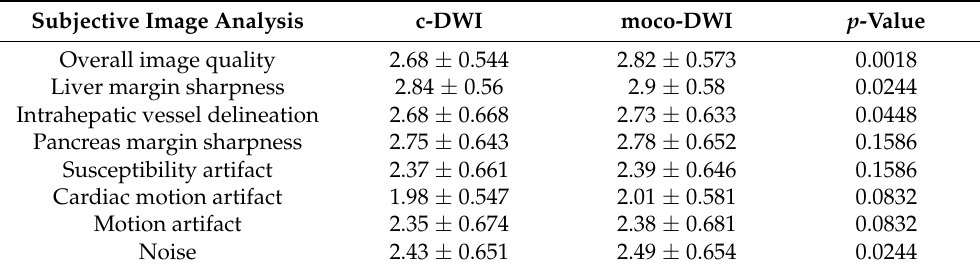
Table 2. Comparison of qualitative analysis between c-DWI and moco-DWI.